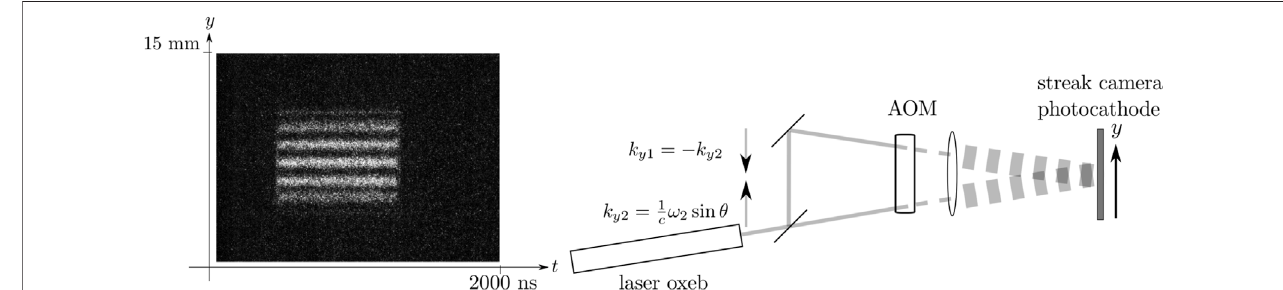
FIGURE 5 | Zero slope interference fringes. Photons are no longer frequency distinguished.